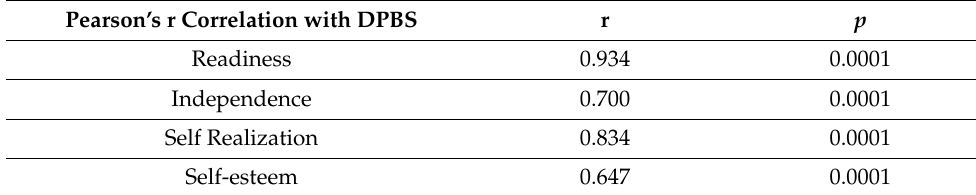
Table 10. Pearson’s r correlation subscales with DPBS.